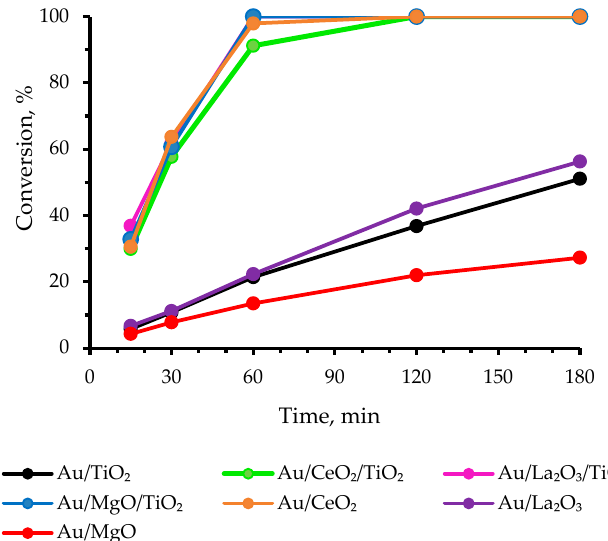
Figure 1. E ff ect of the nature of the support on the oxidation of glycerol on Au / MxOy catalysts: Figure 1. Effect of the nature of the support on the oxidation of glycerol on Au/MxOy catalysts: evolution of conversion with run time. Reaction conditions: T = 50 ◦ C, 0.3 M Glycerol (H 2 O), evolution of conversion with run time. Reaction conditions: T = 50 °C, 0.3 M Glycerol (H ₂ O),